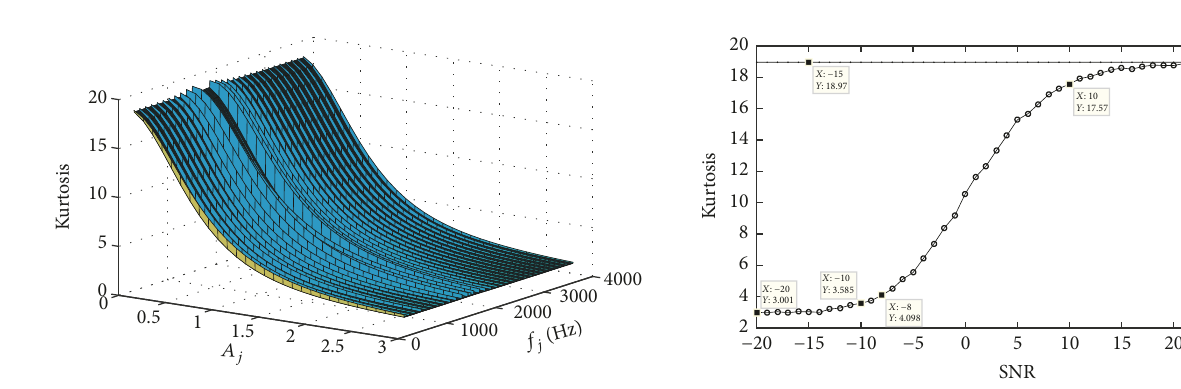
Kurtosis of signals with noise Kurtosis of signals without noise Figure 7: Illustration of the influence of SNR on kurtosis values.